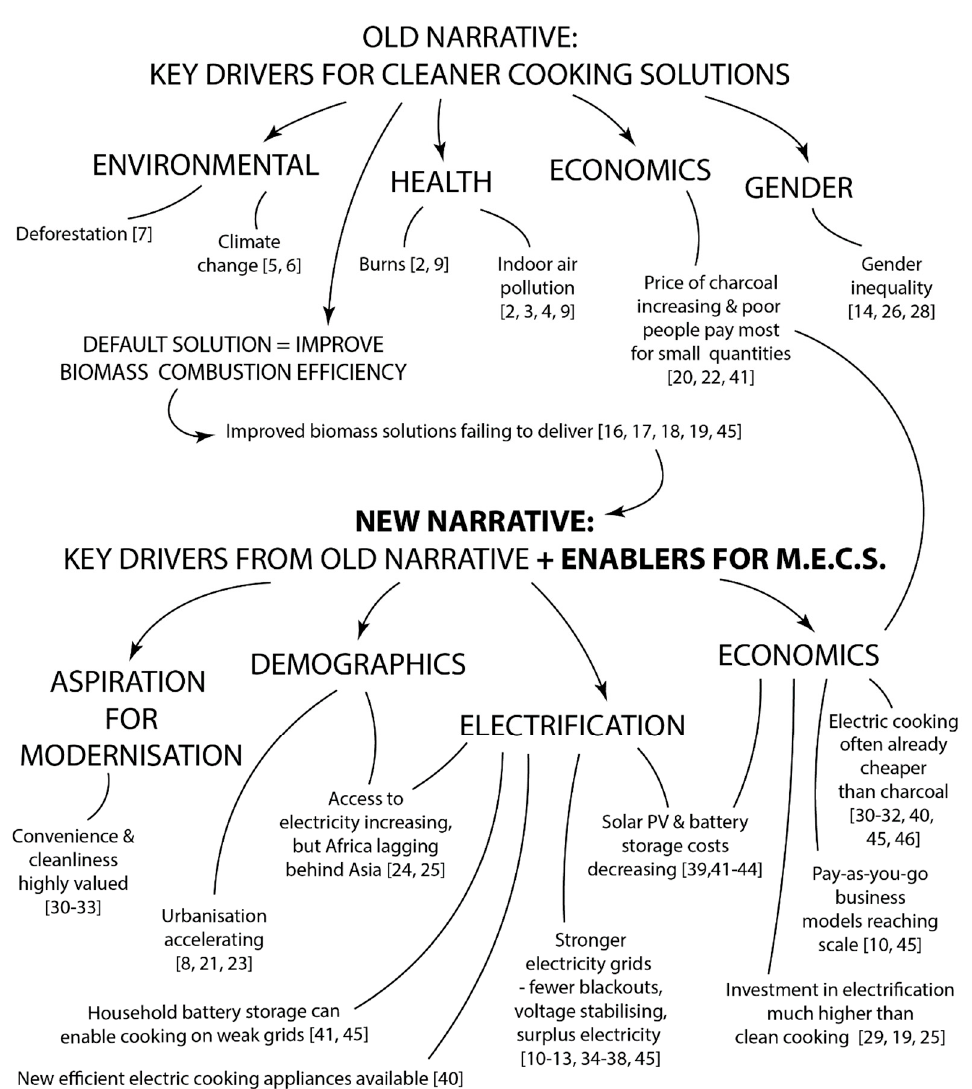
Figure 1. Graphical overview of sources and flow of argument.